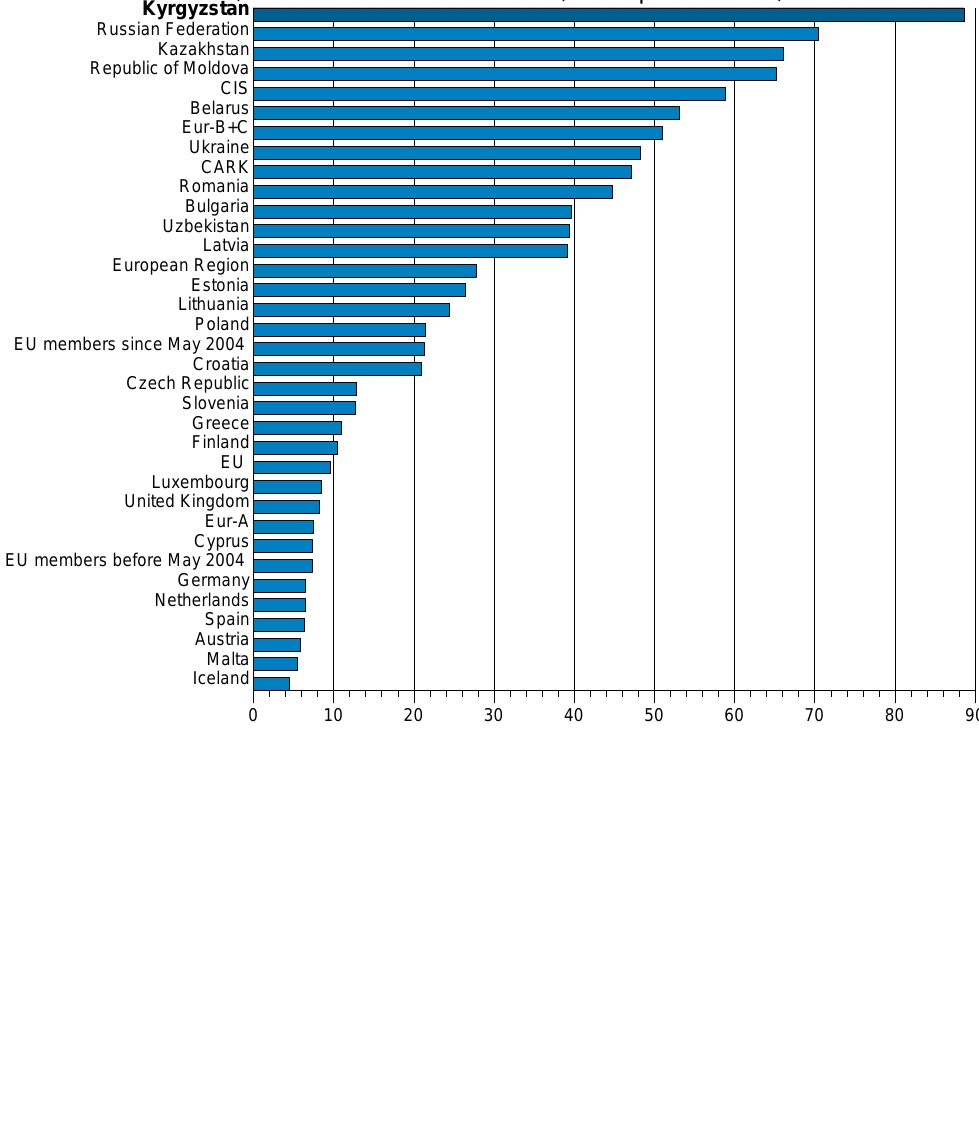
Figure 3: Standardized death rate from cerebrovascular diseases (per 100,000 population, WHO,